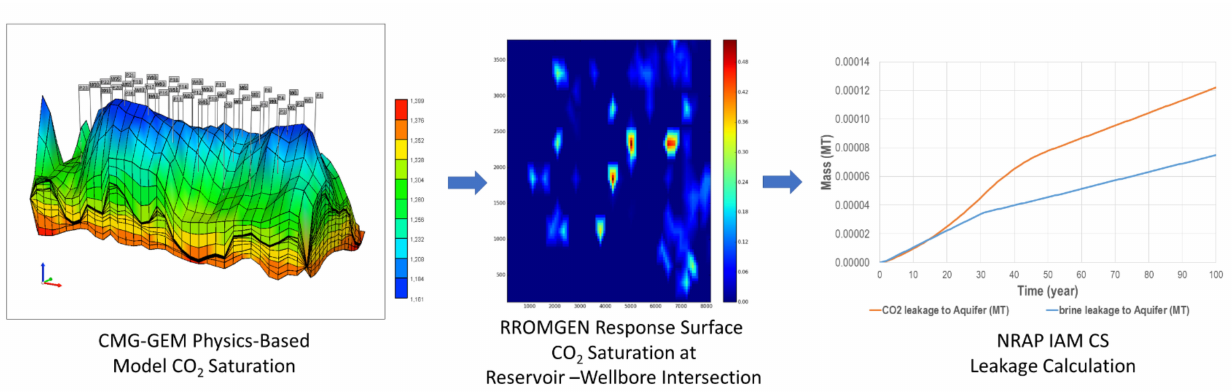
Figure 5. Workflow from physics-based simulators to leakage calculations using National Risk Assessment Partnership (NRAP)